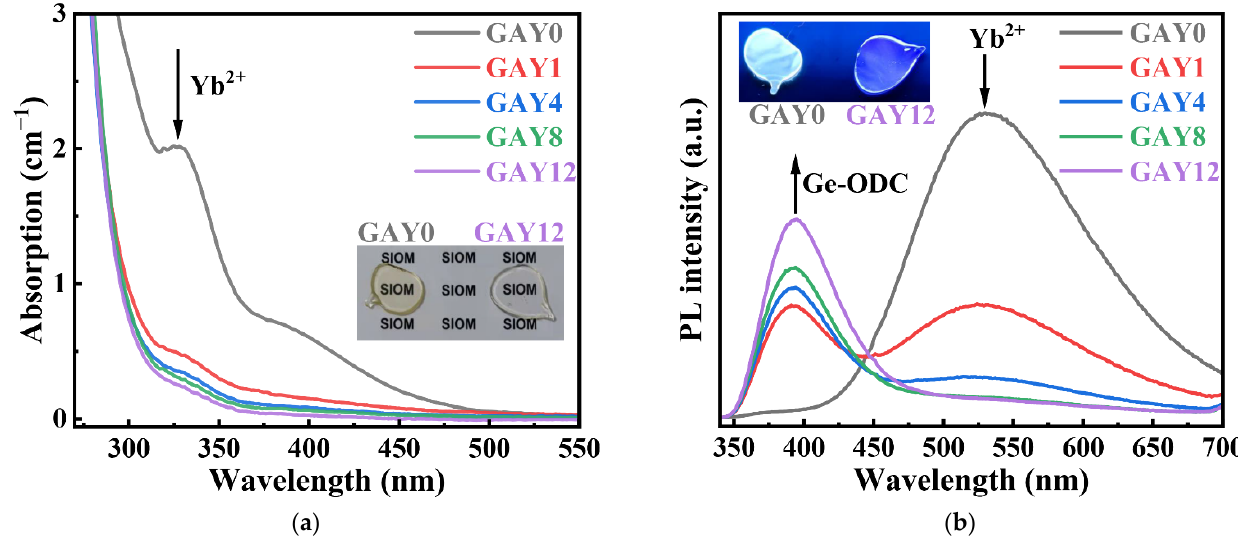
Figure 2. ( a ) Absorption and ( b ) fluorescence of pristine GAY samples; comparison photographs of GAY0 and GAY12 samples (inset in ( a )) under natural light and (inset in ( b )) under ultraviolet light.